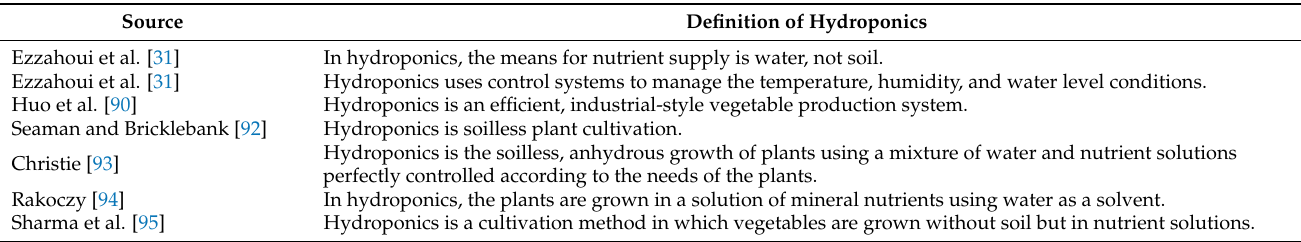
Table 4. Definitions of